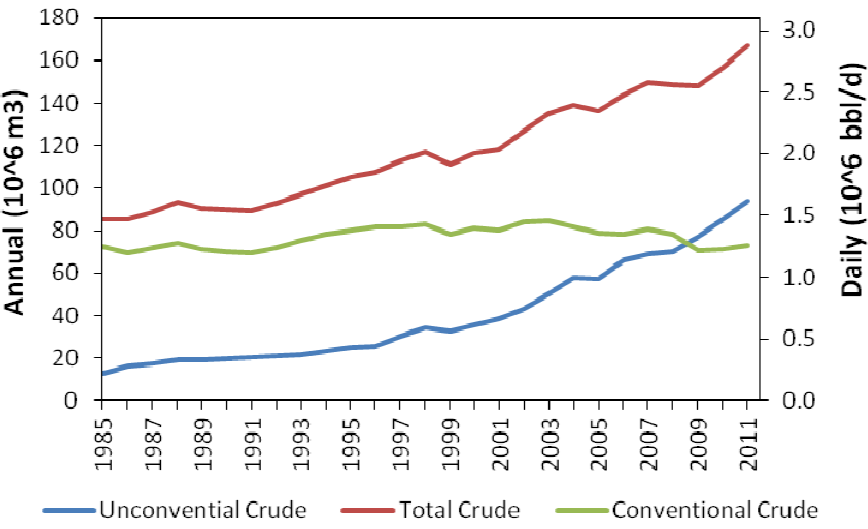
Figure 1. Canadian Crude Oil Production, conventional and unconventional